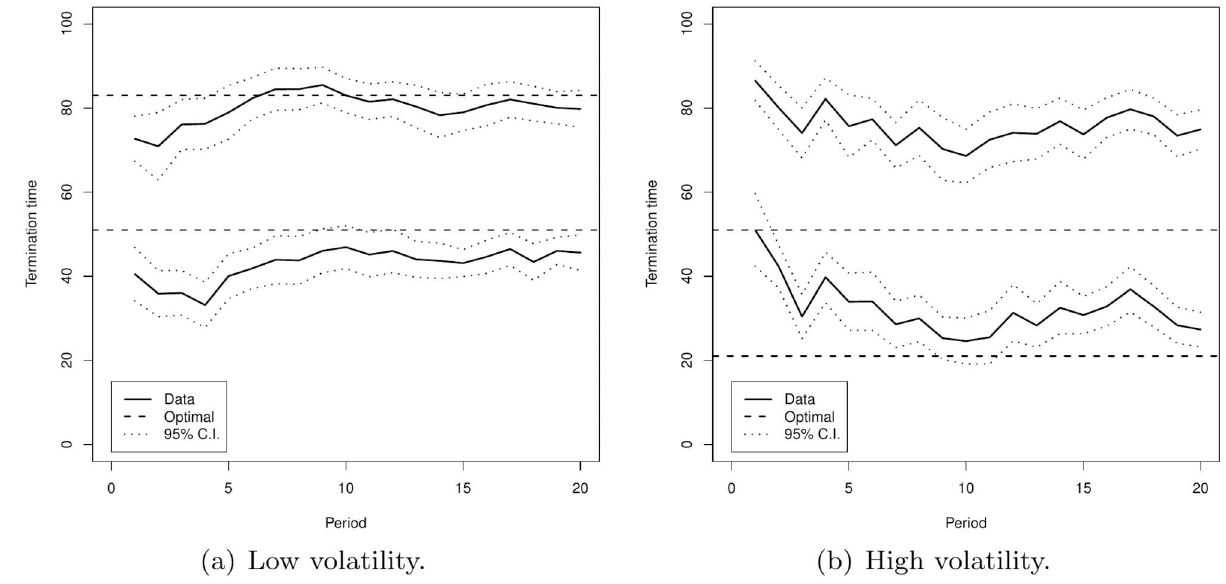
Fig 3. The solid lines indicate the averageintervals (identified by the averagelower an upper bounds) over time. The dashed lines indicate the optimalintervalsfor a risk neutral individual and the dotted lines indicatethe 95% confidenceintervalaroundthe averageupper and lower interval